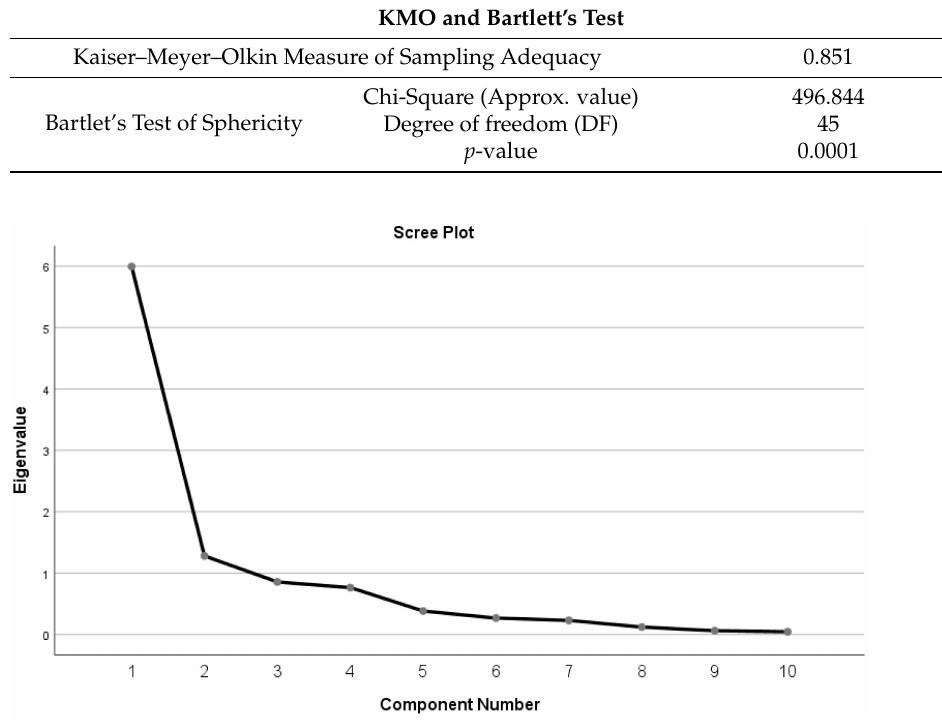
Figure 4. Scree plot and eigenvalue of studied